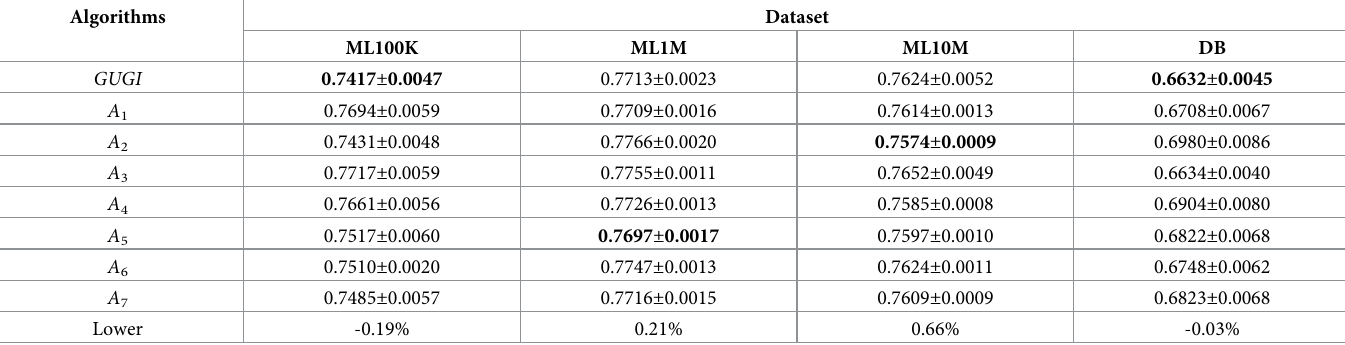
Table 7. MAE comparison under k -means